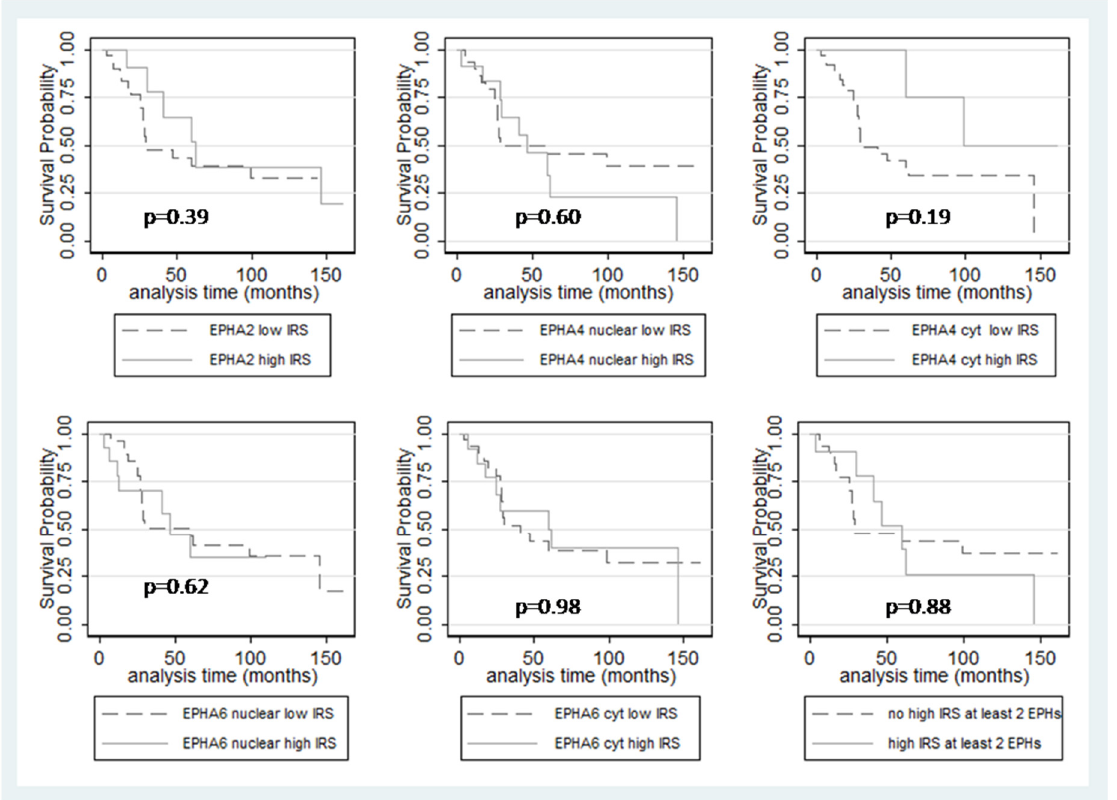
Figure 3. Kaplan–Meier survival curves according to EPHA2, EPHA4, EPHA6 IRS, as well as concurrent overexpression of at least two of the investigated EPHs.